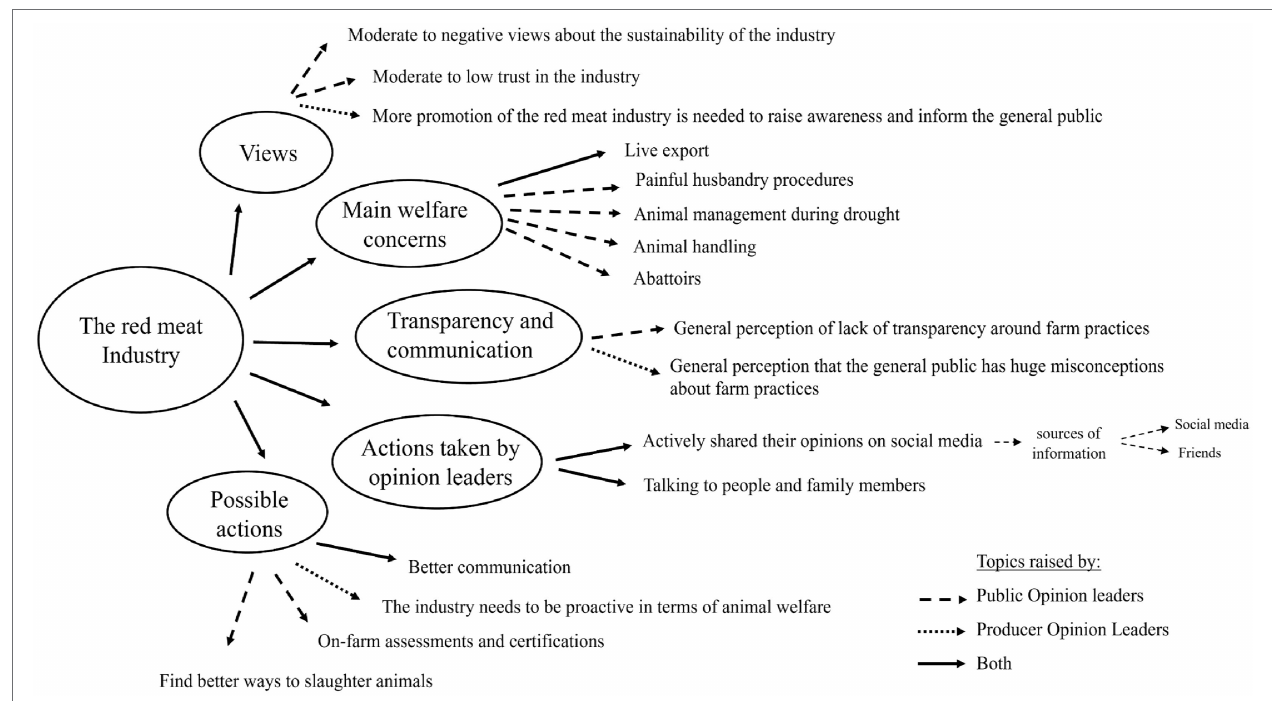
FIGURE 1 | The hierarchy of themes generated using a grounded theory